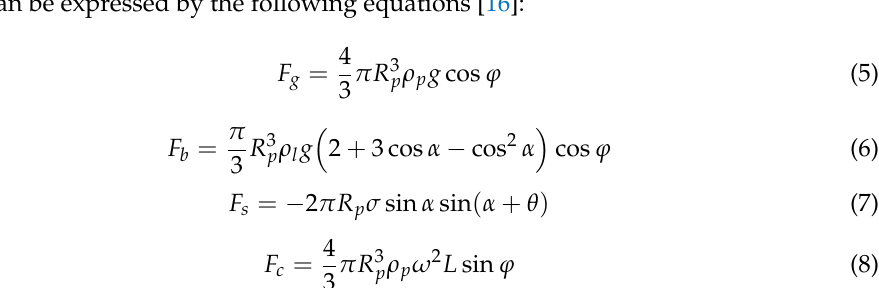
philic ( b , d ) and hydrophobic ( c , e ) particles. ( b , d ) and hydrophobic ( c , e )